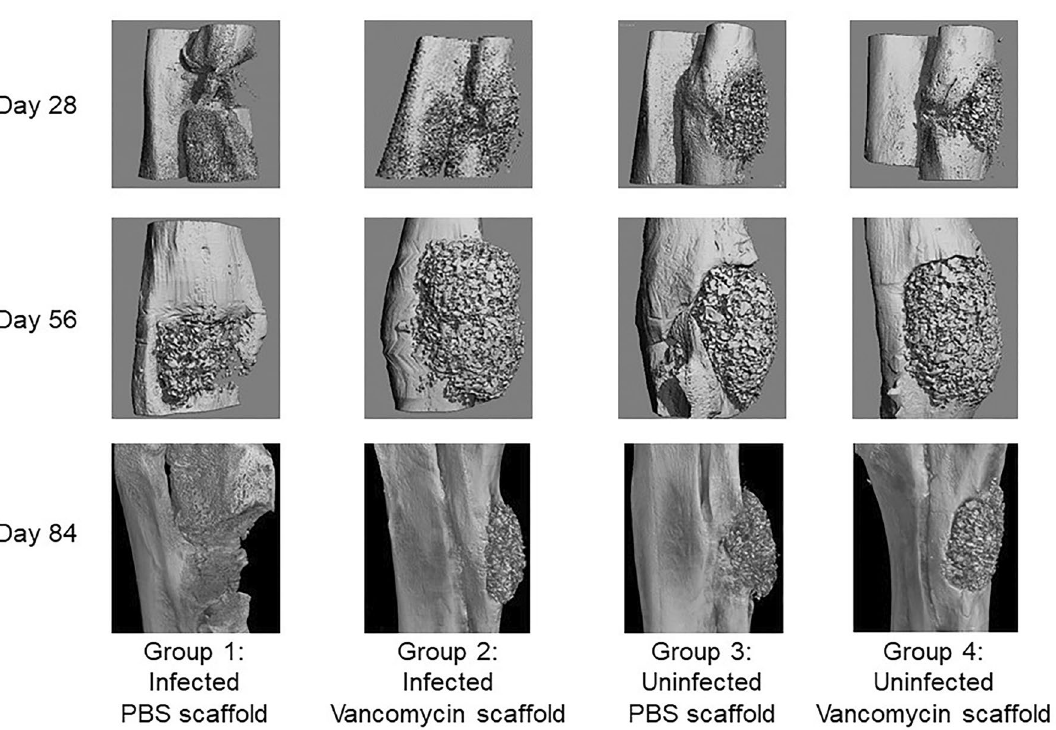
Figure 4. µCT analysis of K20/100 scaffold formulation. Bone surrounding the surgical site was harvested 28, 56, or 84 days post-surgery and subjected to µCT analysis. Results shown are from representative rabbits from each experimental group, with the specific experimental group indicated below each set of vertical